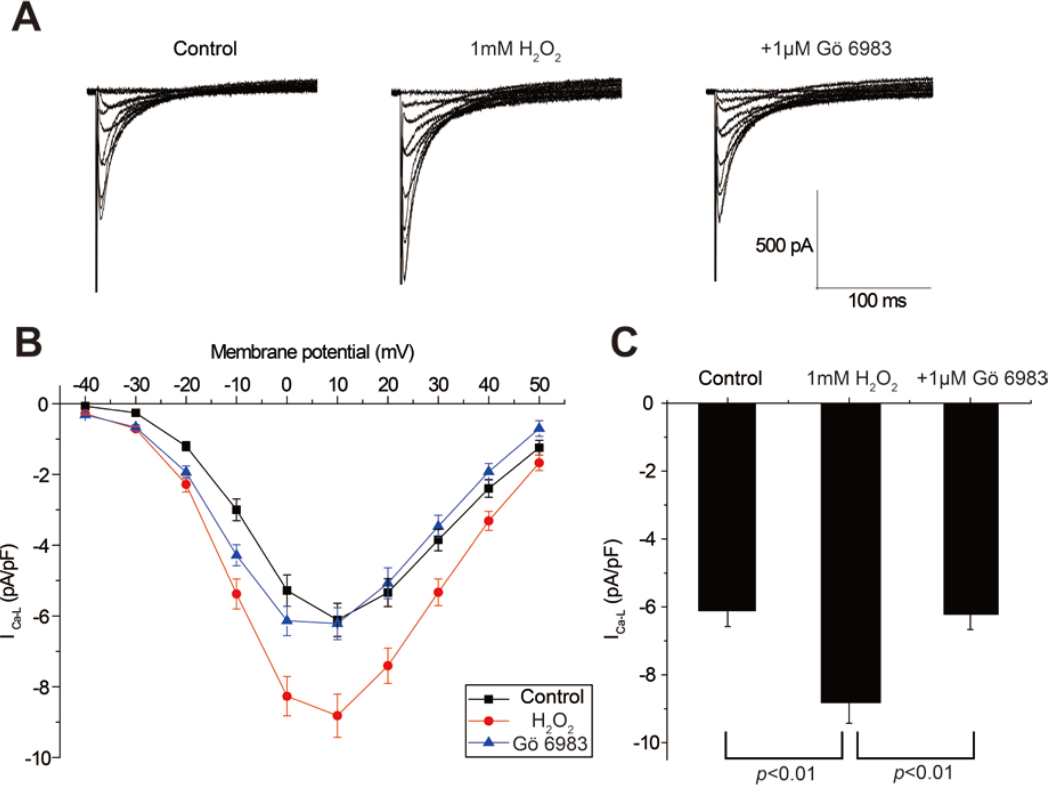
Figure 4. Effects of Gö 6983 on H 2 O 2 -induced L-type calcium current (I Ca,L ) elevation. Representative current-voltage traces ( A ) and the averaged current-voltage curves ( B ) showed that H 2 O 2 significantly augmented I Ca,L , which was reversed by Gö 6983. Summary histogram ( C ) of I Ca,L at +10 mV under control condition, in the presence of 1 mM H 2 O 2 alone or plus 1 µ M Gö